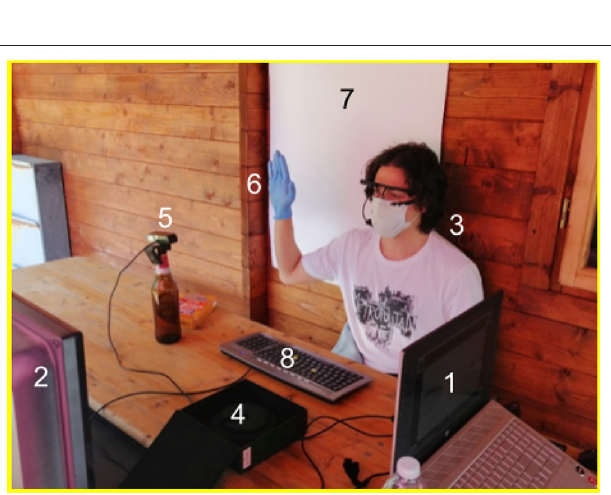
FIGURE 5 | Setup of the experiment involving: (1) Experimenter’s computer used to control the whole system through dAIsy; (2) Screen where the streaming images seen by the drone are shown to the participant; (3) Experiment participant wearing the eye-tracking Pupil Core goggles for gaze identification; (4) container used to host the fragile Pupil Core goggles during intervals between different experimental sessions; (5) Webcam to detect hand gesture; (6) Hand with glove for gesture recognition; (7) White background to facilitate hand gesture recognition; (8) Keyboard of the traditional interface.